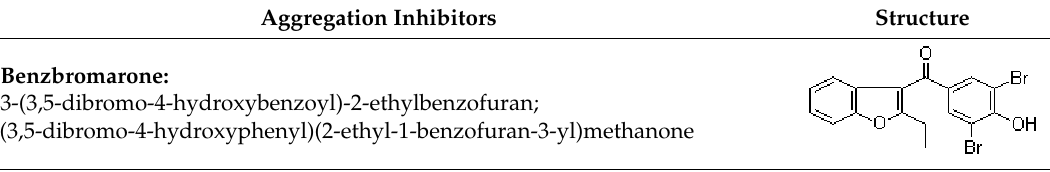
Table 1. Common names, systematic names, and chemical structures of three inhibitors of amylin (8–37) aggregation. Aggregation Inhibitors Structure